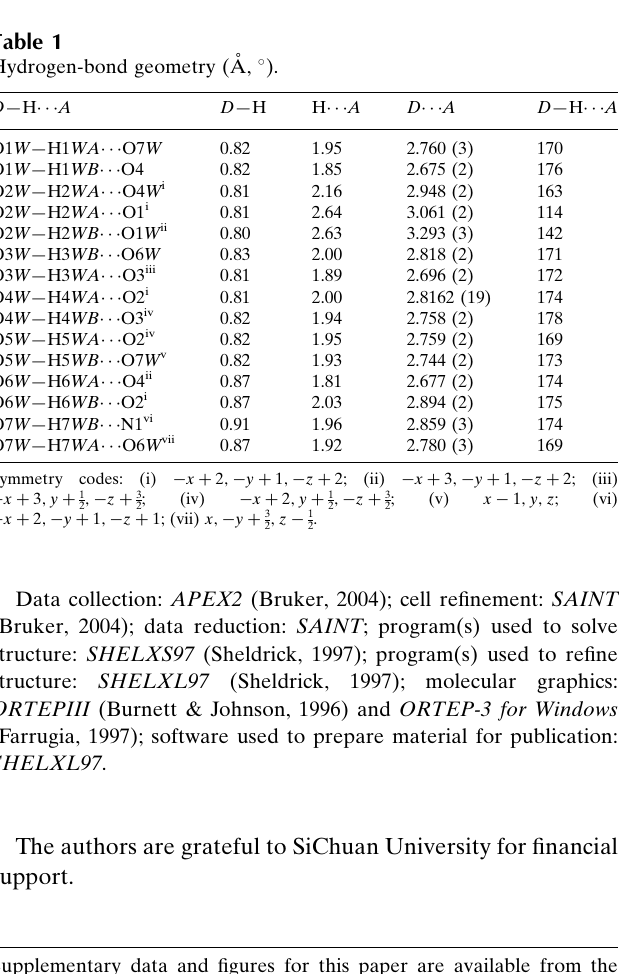
Hydrogen-bond geometry (A˚ , (cid:2)